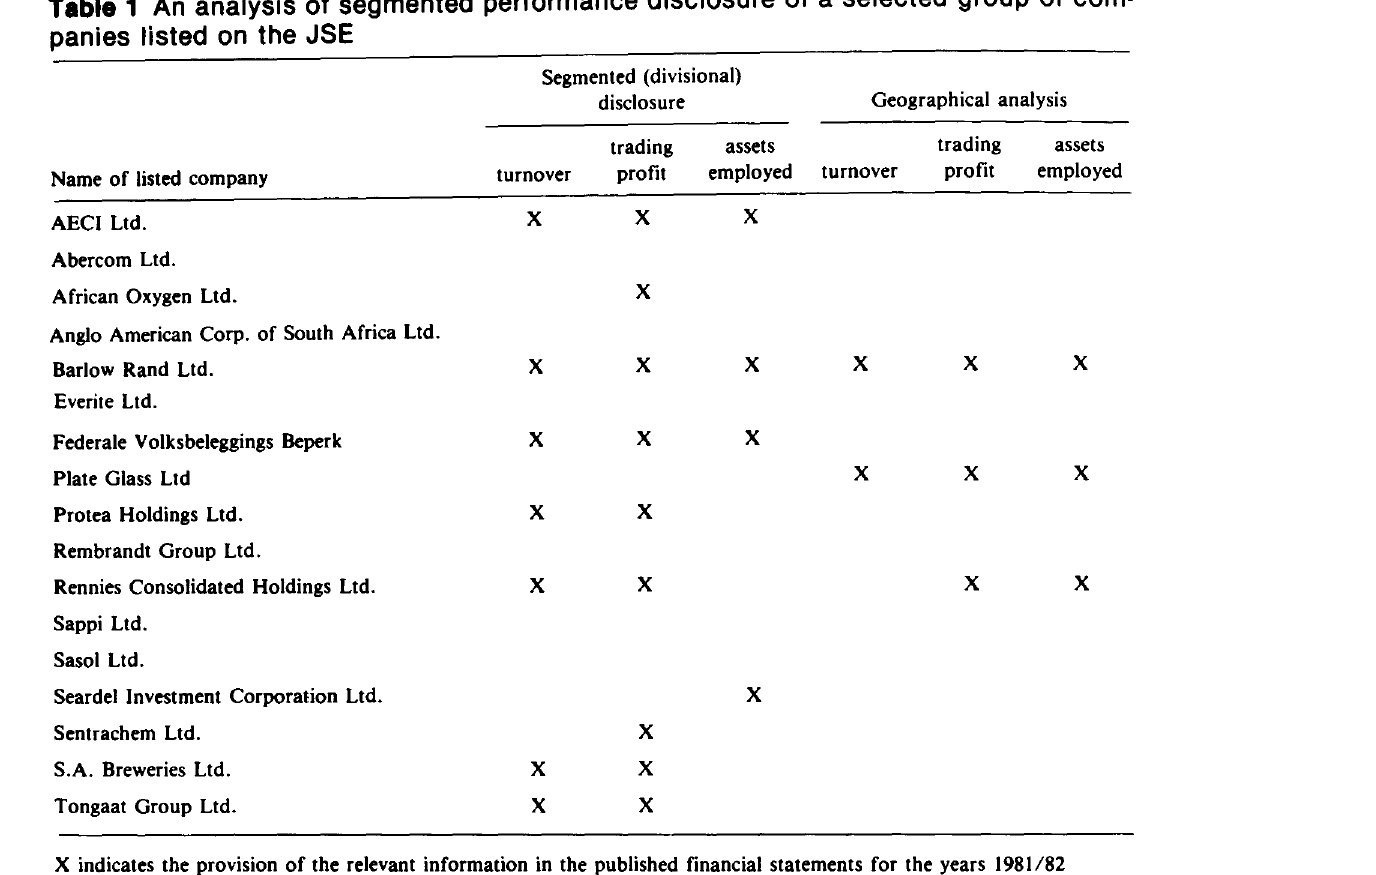
Table 1 An analysis of segmented performance disclosure of a selected group of com- panies listed on the JSE Segmented